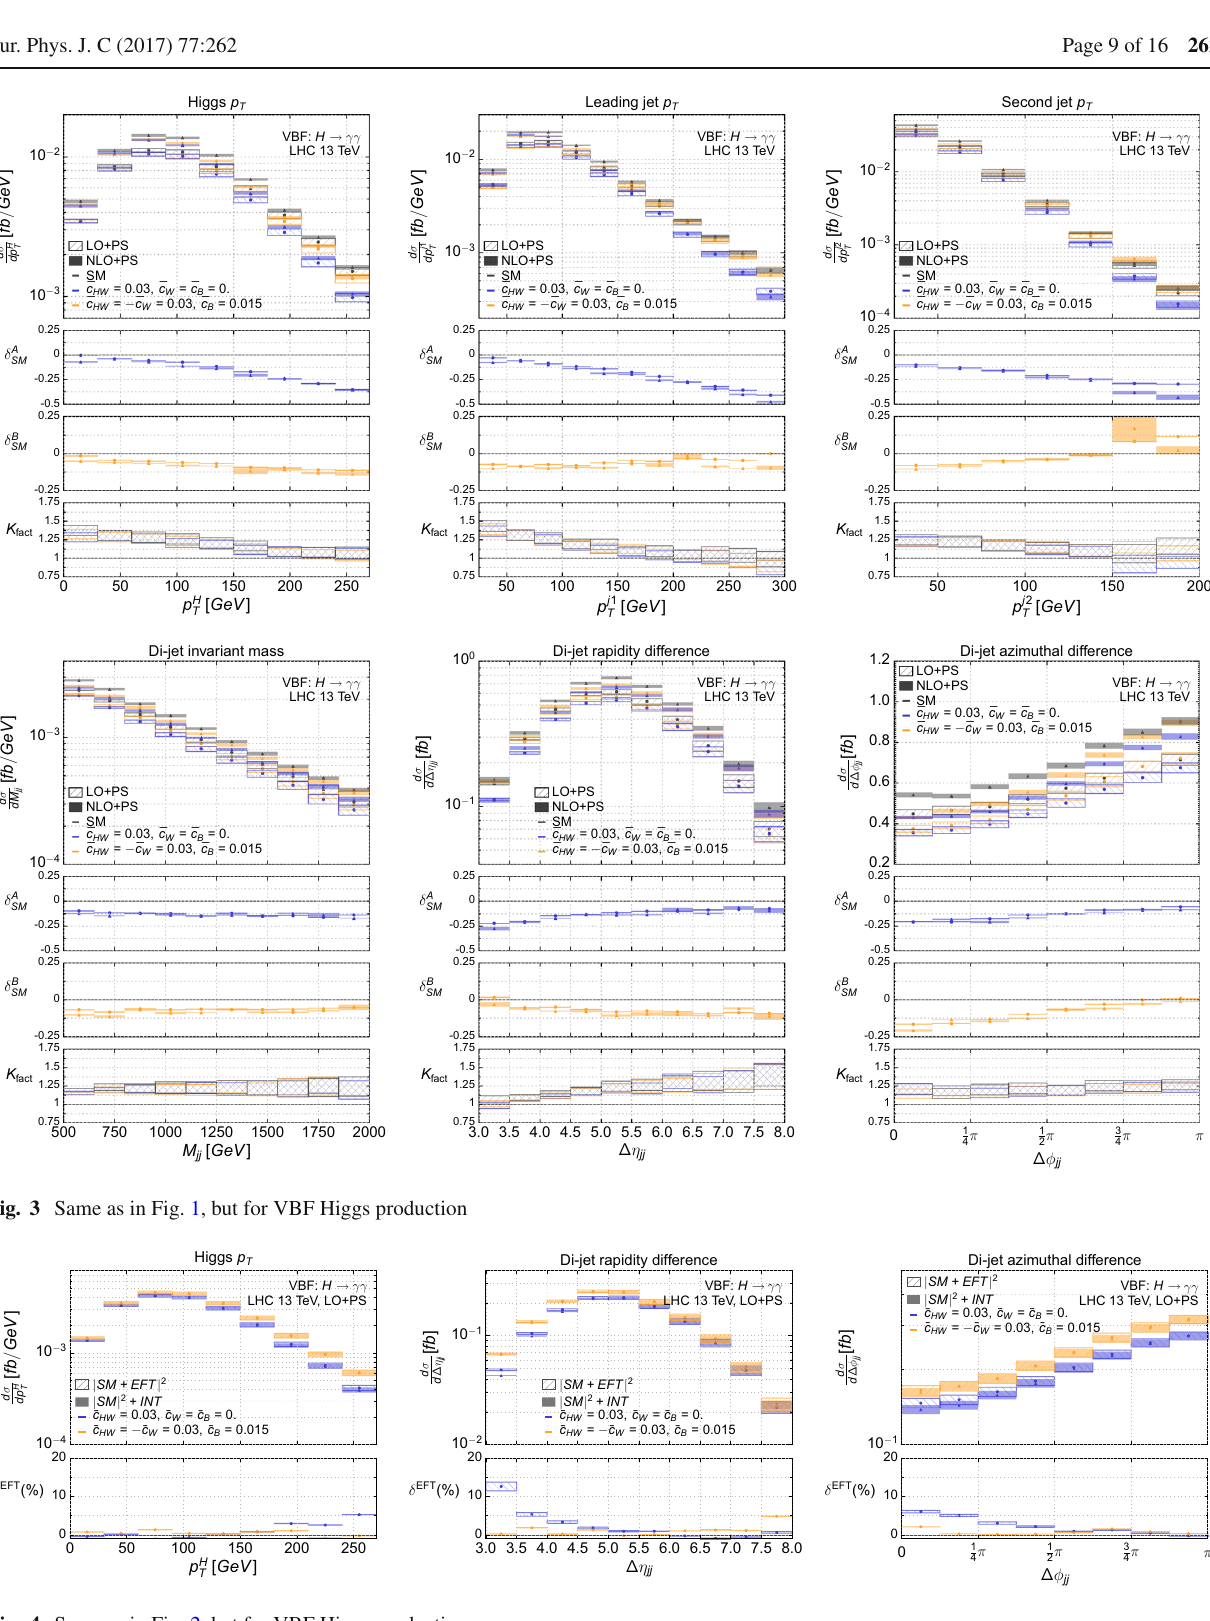
Fig. 4 Same as in Fig. 2, but for VBF Higgs